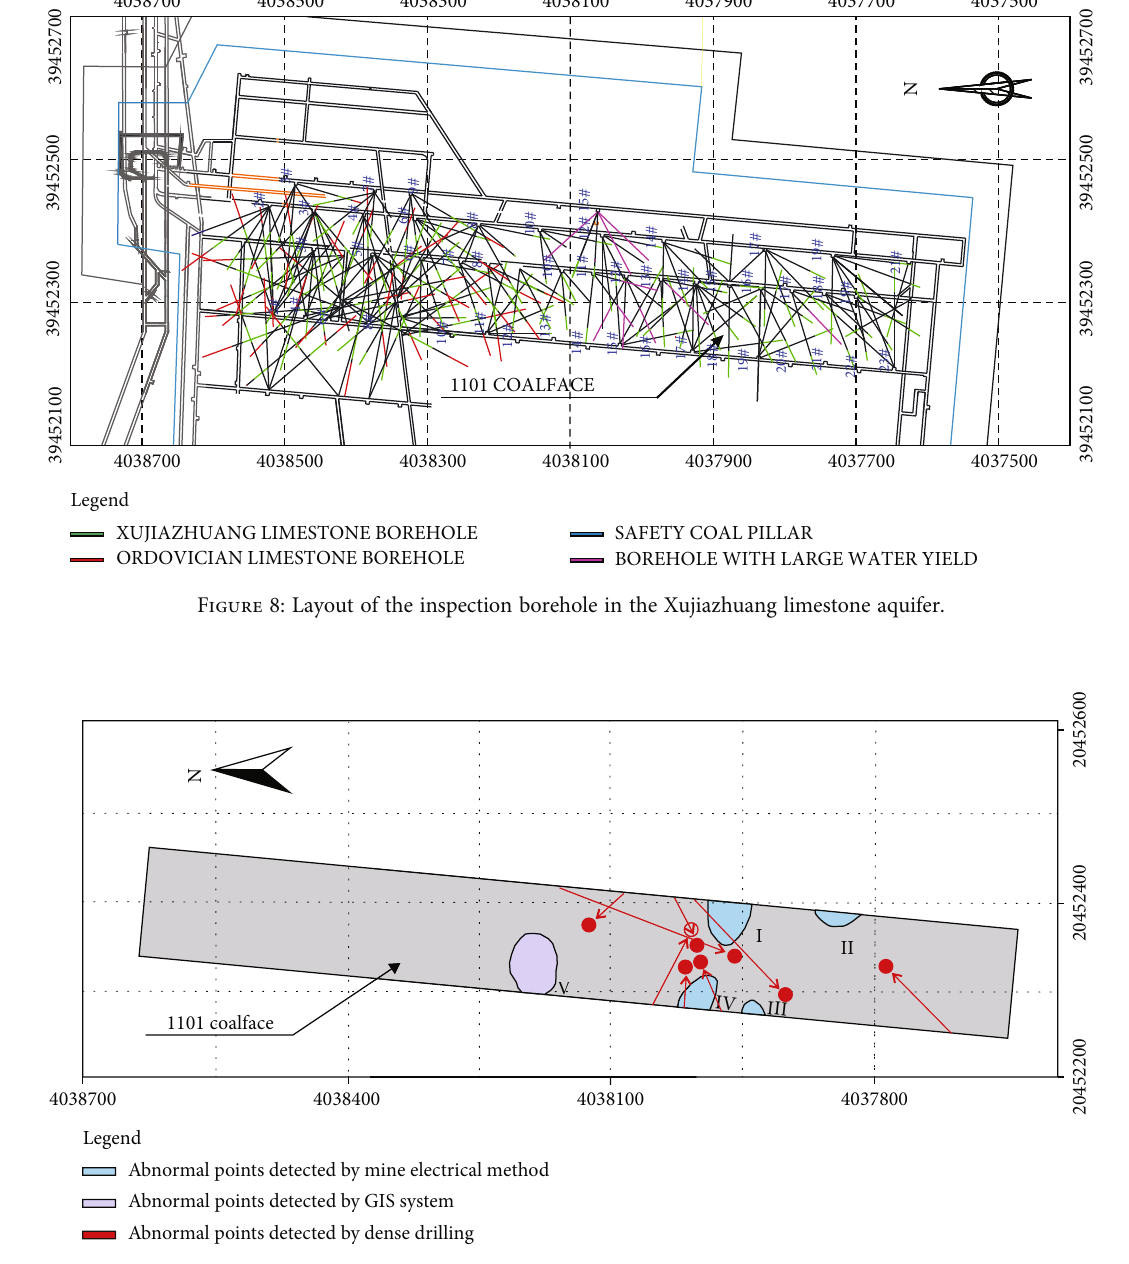
Figure 9: Evaluation chart of the fl oor water disaster control e ff ect in 1101